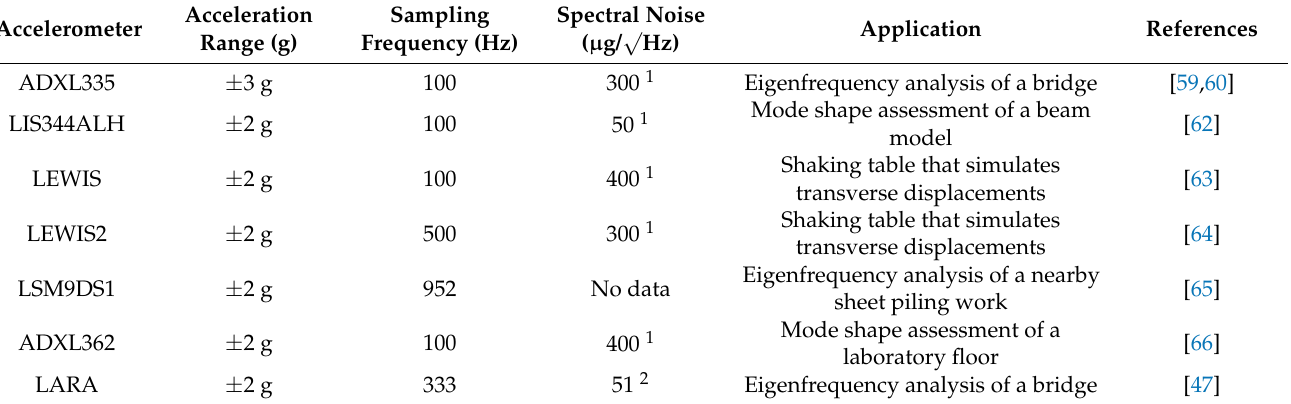
Table 2. Low-cost solutions in the literature to measure